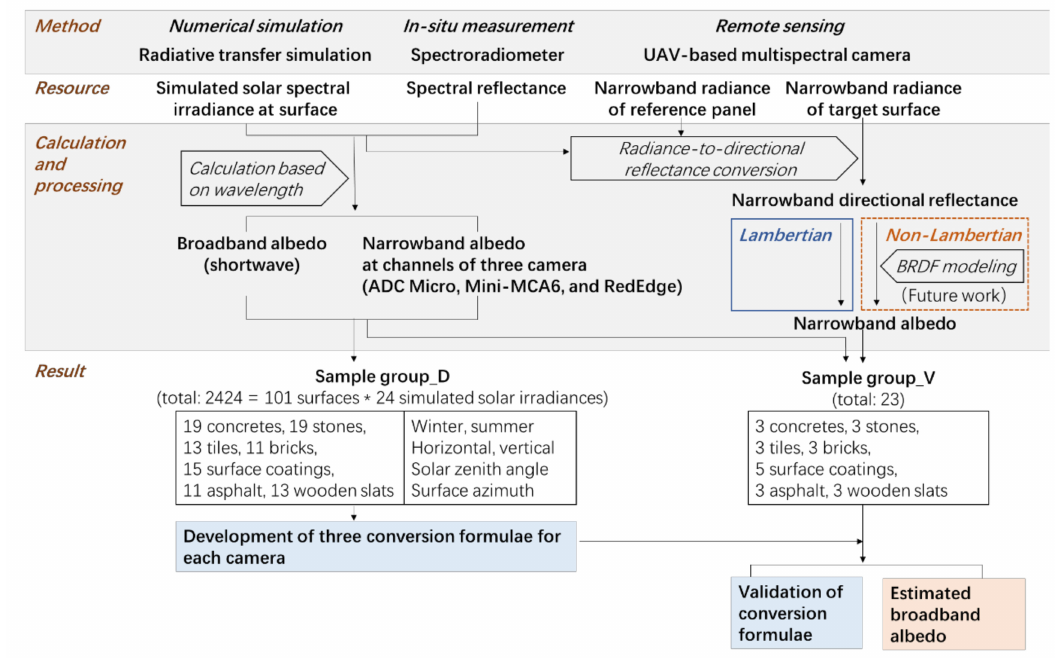
Figure 2. Technical process used to develop conversion models and to validate their